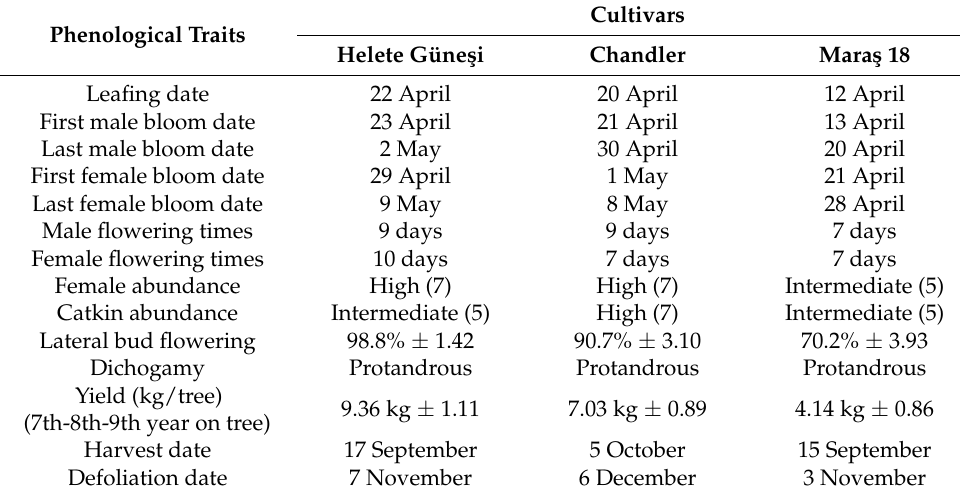
Table 3. Phenological traits of ‘Helete Güne¸si’ and its parents.